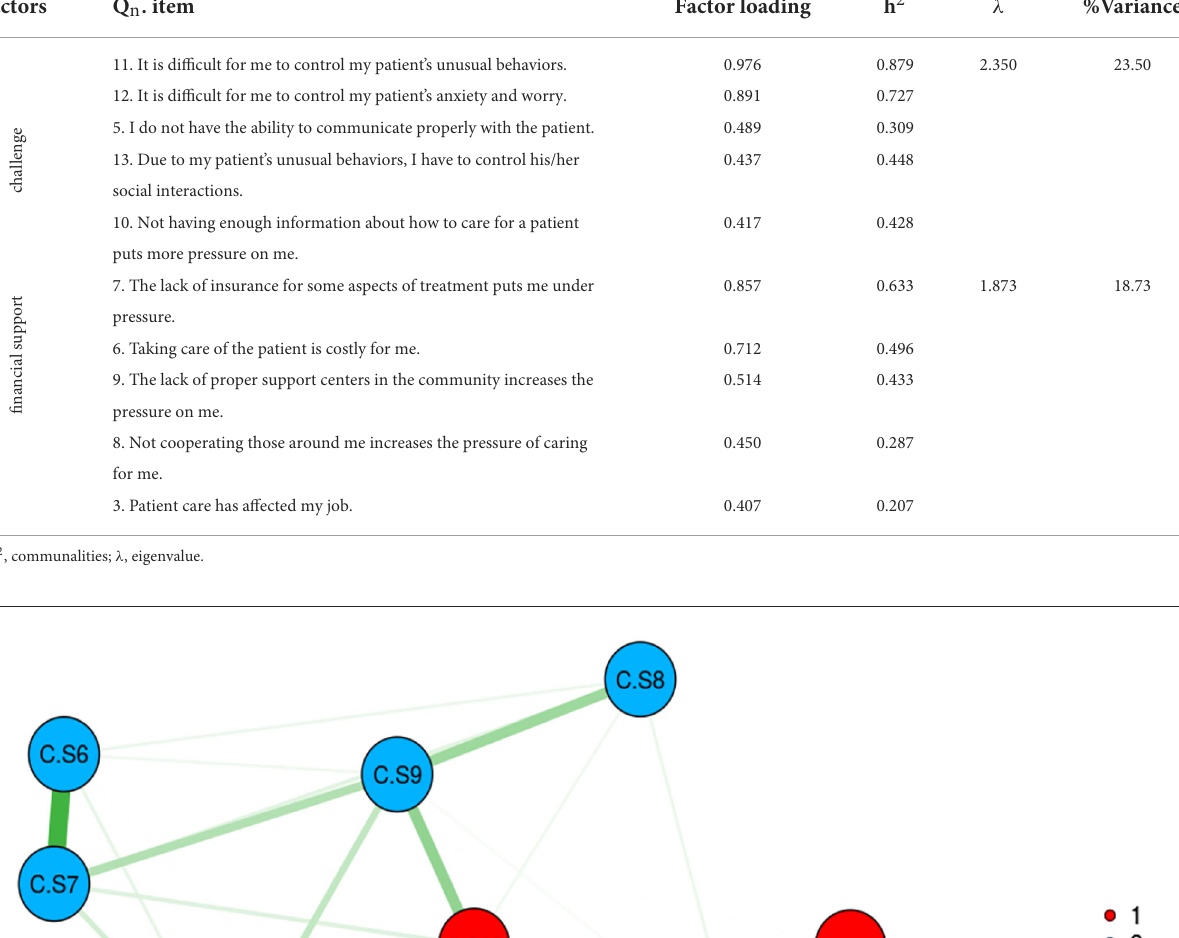
TABLE 3 Result of EFA on the two factors of CCS ( n Factors Q n . item